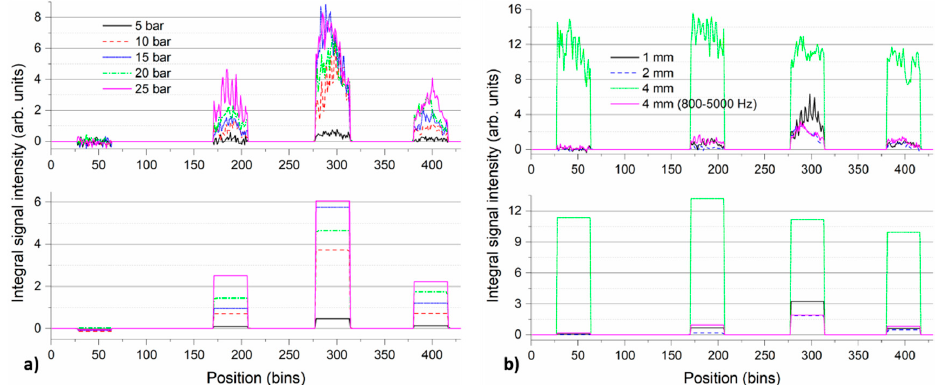
Figure 10. Integral spectral intensity of the detected DAS signals along the fiber for the measurement series with 1 mm leak at different pressure levels ( a ) and for the measurement series at constant pressure level of 10 bars and different leak sizes ( b ). The time-averaged spectra of DAS signals from individual measurements were integrated in 500–5000 Hz range. Additional curve for 4 mm leak at 10 bars using spectral integration in 800–5000 Hz range is included in plot ( b ). Top-row graphs show spectrally-integrated signals for individual bins in the four pipe zones. Bottom-row graphs show corresponding zone-averaged signal integral spectral intensities.